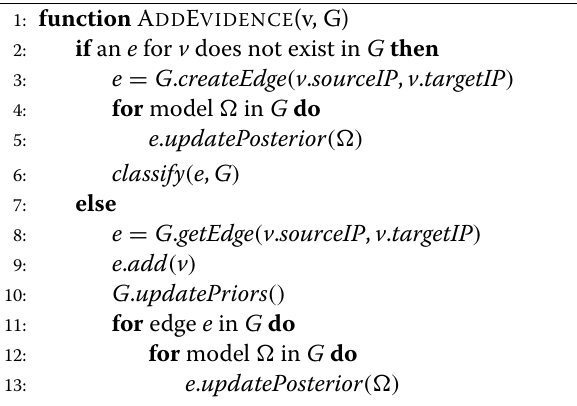
Algorithm 1 Add evidence v to a new or existing edge e in an attack graph G where a dynamic attack model is represented by (cid:2) .